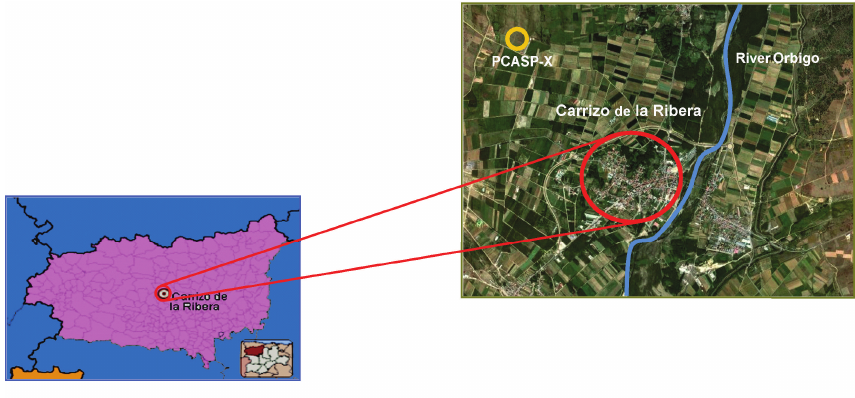
Figure 1: Location of Carrizo de la Ribera in the province of Le´on. Location of the PCASP-X probe and the river ´Orbigo, with respect to the town.